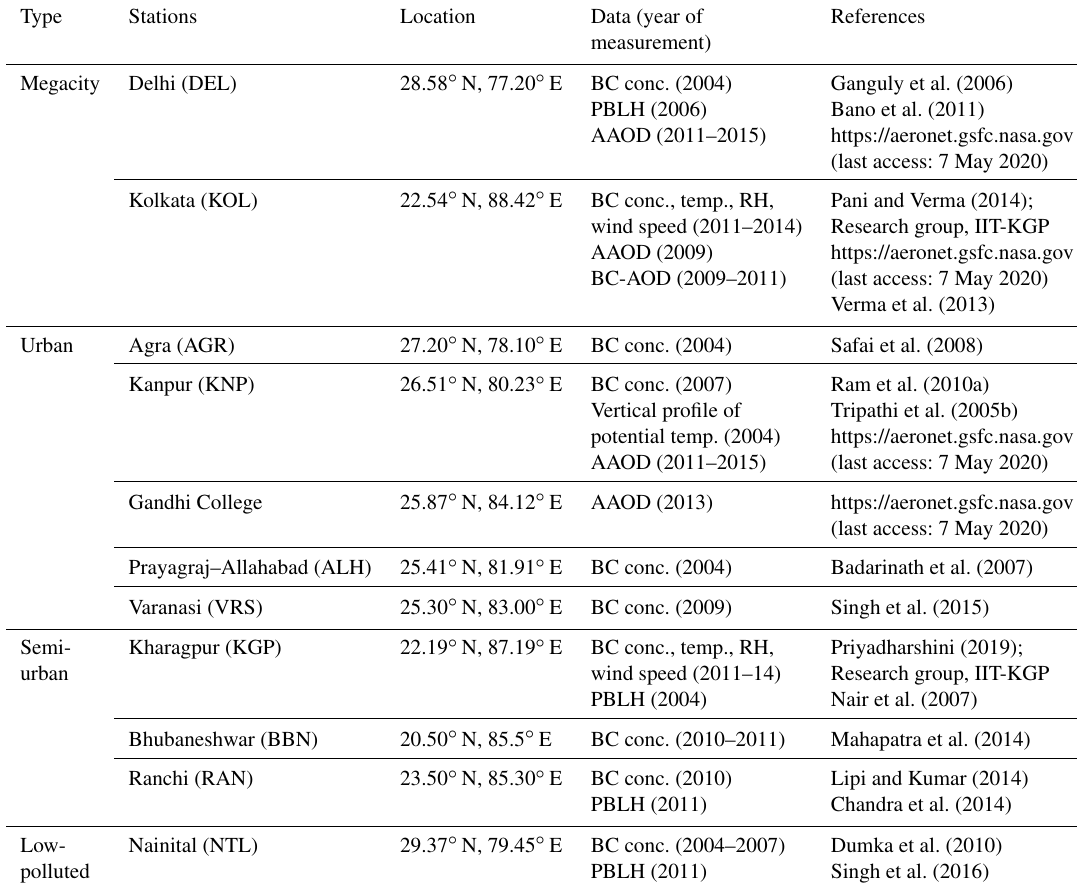
Table 2. Observational data used for model validation from available studies at identified locations over the study